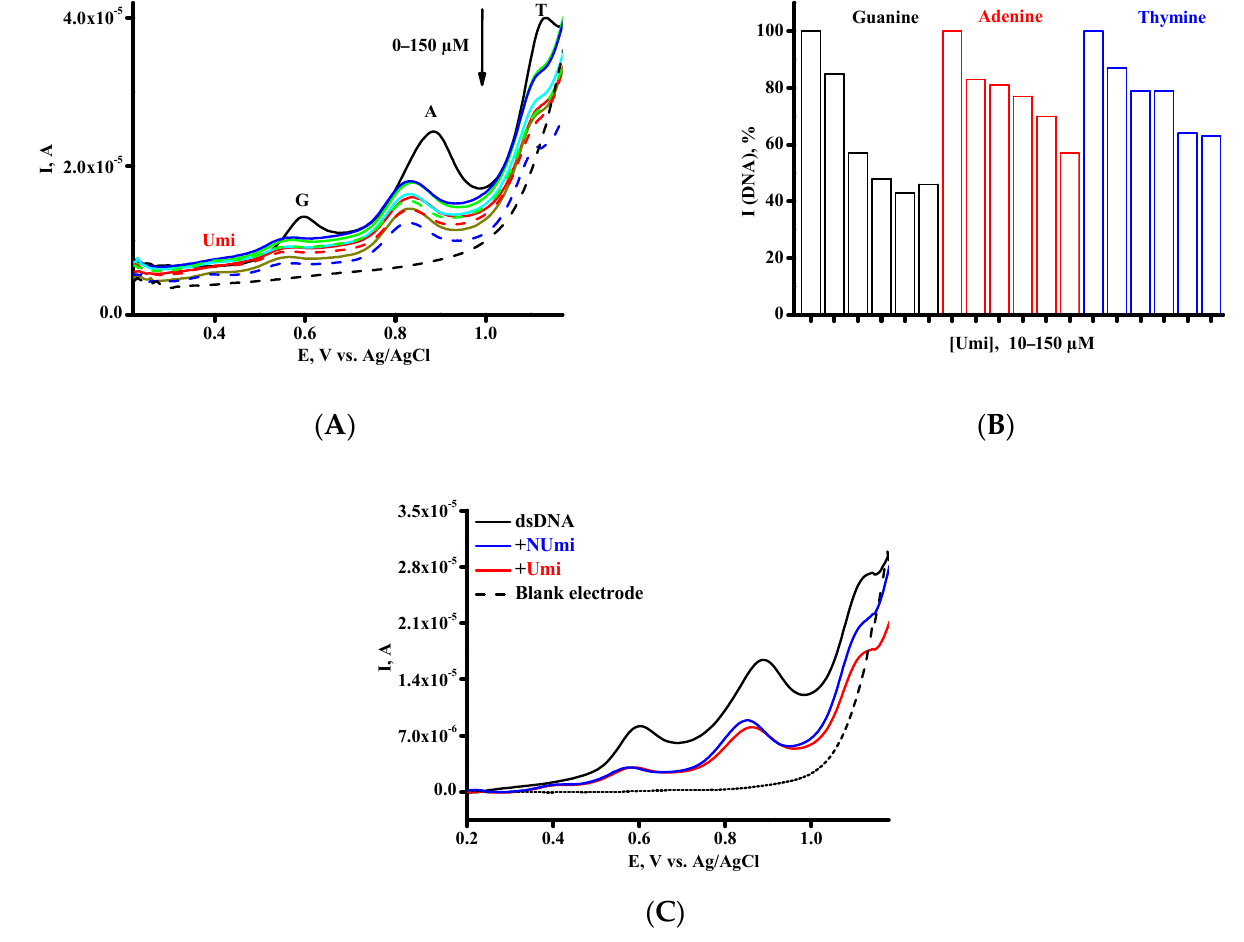
Figure 4. ( A ) DP voltammograms of dsDNA in the absence (black line) and in the presence of Umi in the concentration range of 10–150 µM, SPE/SWCNT (dash line); ( B ) Histograms corresponding to the average guanine, adenine, and thymine signals after the addition of Umi in the range of concentration 10–150 µM; ( C ) DP voltammograms of dsDNA in the absence (black line) and in the presence of 70 µM Umi (red line) and in the presence of 70 µM NUmi (blue line), SPE/SWCNT (dash line).